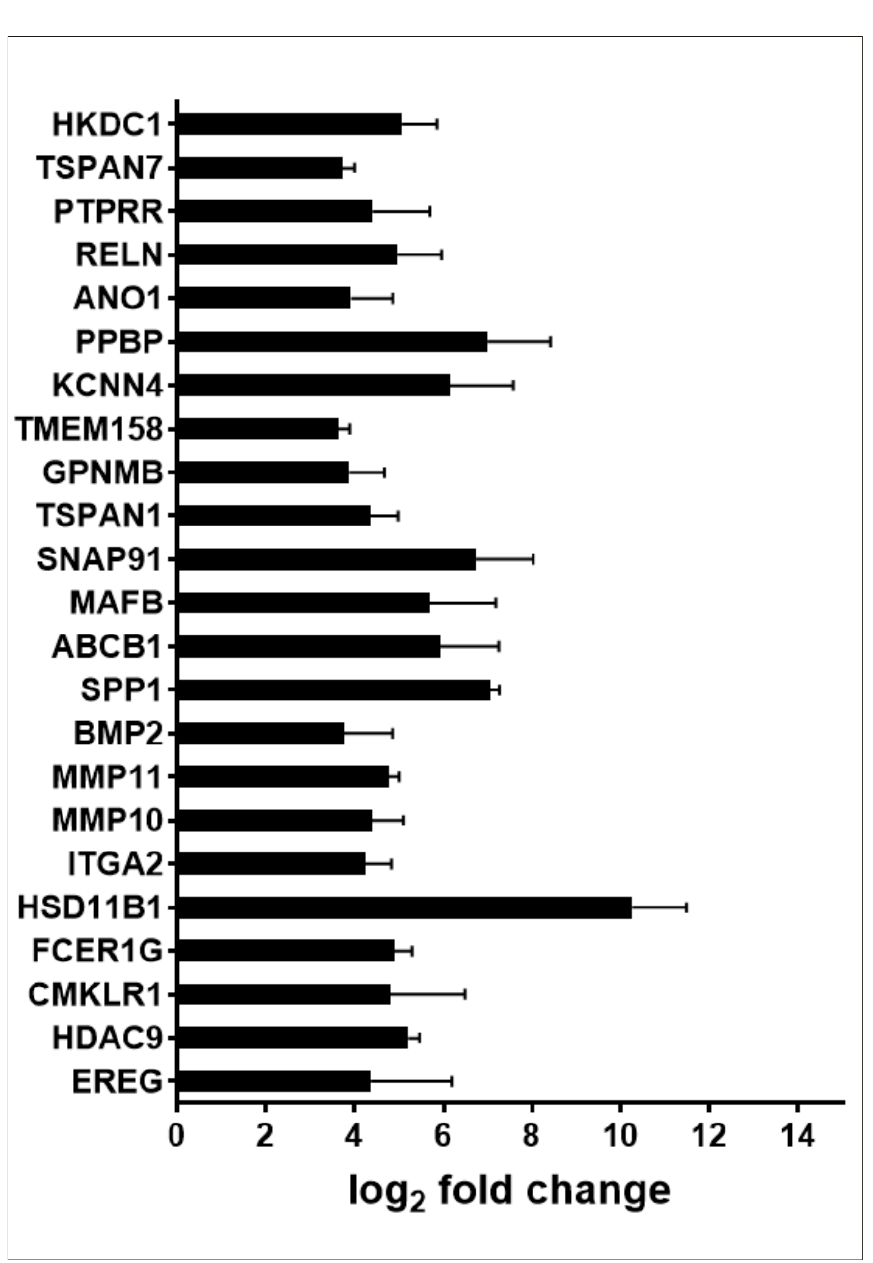
Figure 7. Expression of genes upregulated by K-Ras activation in PMA-treated MO3.13 cells; 23 genes with fold change ≥ |10| are shown.